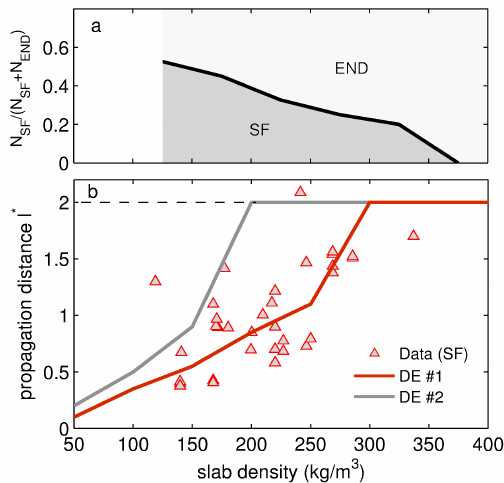
Figure 13. (a) Proportion between the number of experiments with slab fracture N SF and the total number of experiments N SF + N END for different classes of density. (b) Propagation distance l ∗ vs. slab density ρ only for cases with fracture arrest (SF). The red line cor- responds to case #1 and the gray line corresponds to case #2. The dashed line corresponds to the column length L = 2m in the PST